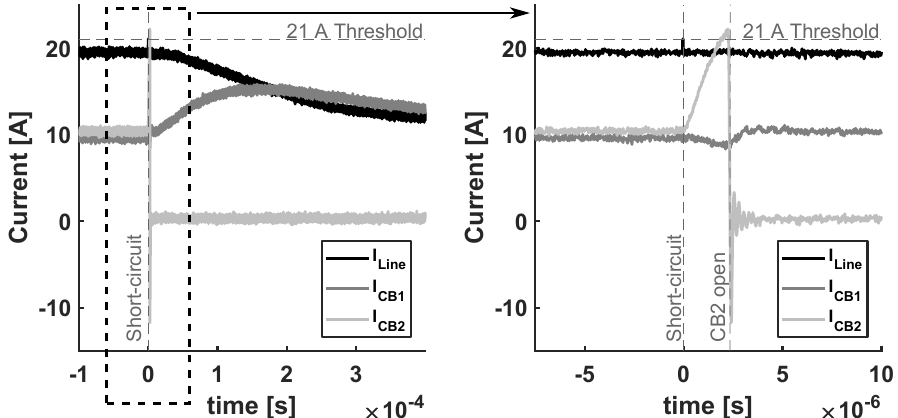
Figure 20. Experimental results for the system shown in Figure 12 when a capacitance of 240 µ F is added at the interface of the plug-and-play SSCBs, showing that the commutated current is reduced (the right figure is a zoom